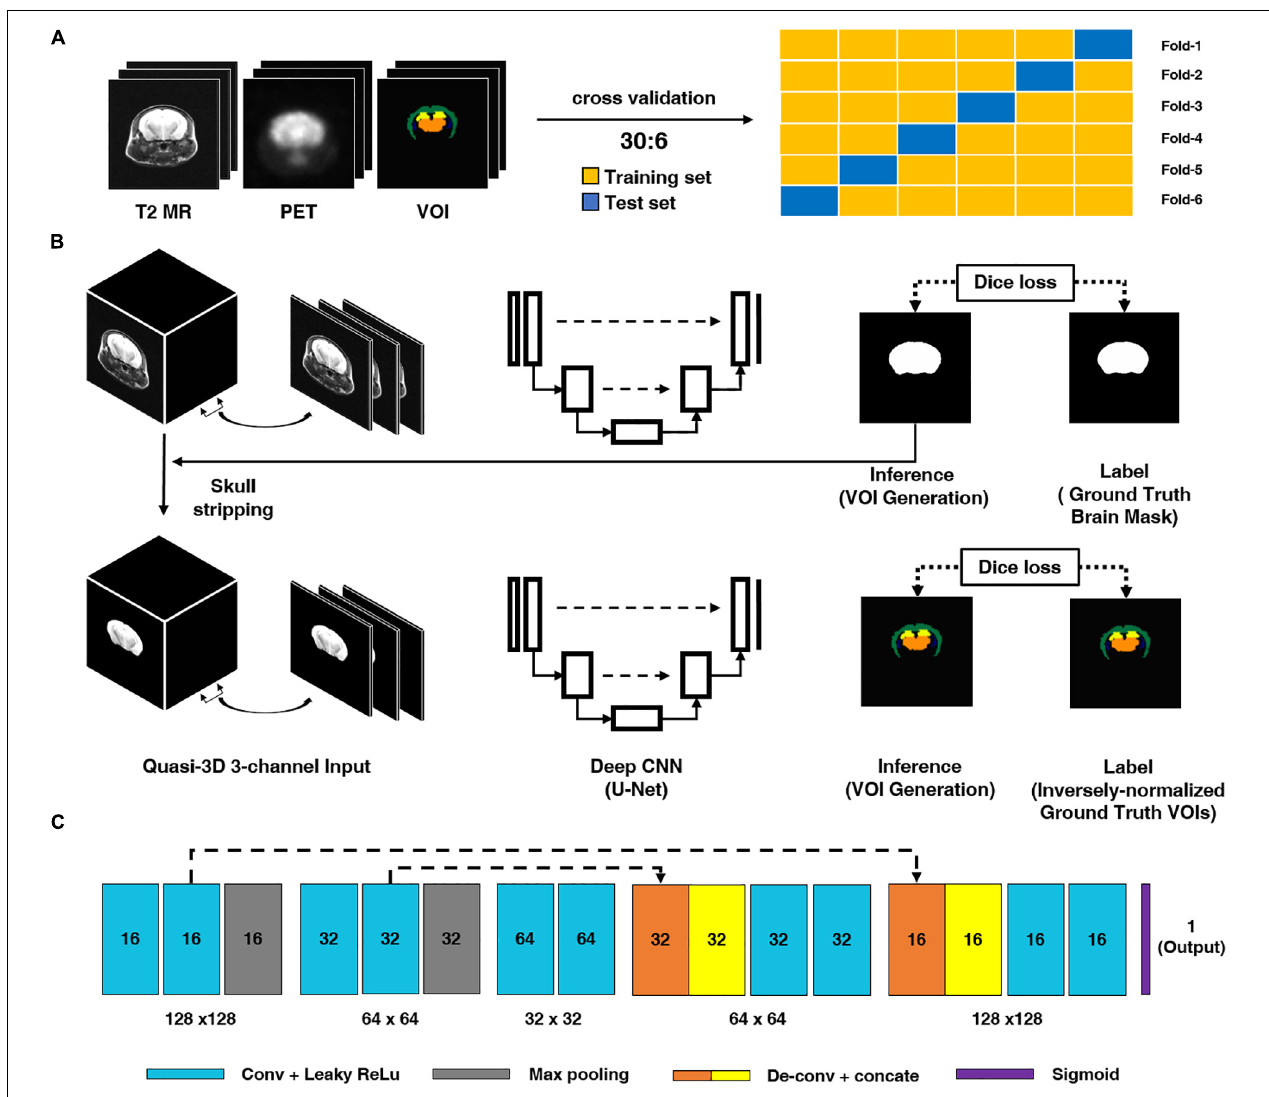
FIGURE 1 | Schematic diagram of the proposed deep CNN model. (A) We conducted six-fold crossvalidation for training and test set separation. (B) Brain parenchymal mask generation deep CNN. For model training, T2-weighted magnetic resonance (T2 MR) imaging was used as an input and manually traced brain mask was used as a label. (B) Inversely normalized volumes-of-interest (iVOIs) in individual brain space generation through deep CNN. For training the deep CNN model, skull-stripped T2 MR was used as the model input and iVOI template was used as the VOIs in individual space (the label for the model). (C) Deep CNN (i.e., U-Net) structure used in this study. The light blue box represents a 3 × 3 convolution and a leaky ReLU followed by max pooling, expressed in gray boxes. The orange and yellow boxes denote the 2 × 2 deconvolution and concatenation operations to increase the accuracy of localization. The dash arrow represents the copying skip connections. The dash arrow represents the copying skip connections. deep CNN, deep convolutional neural network.